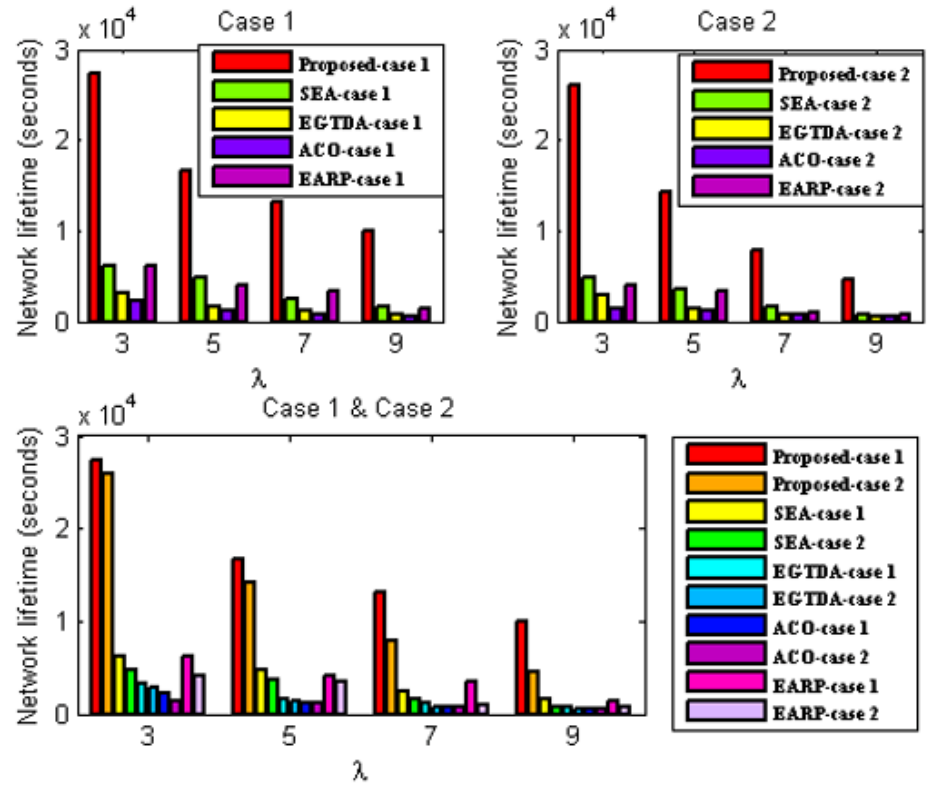
Figure 6. Influence of increasing average traffic rate on network lifetime under the first scenario.